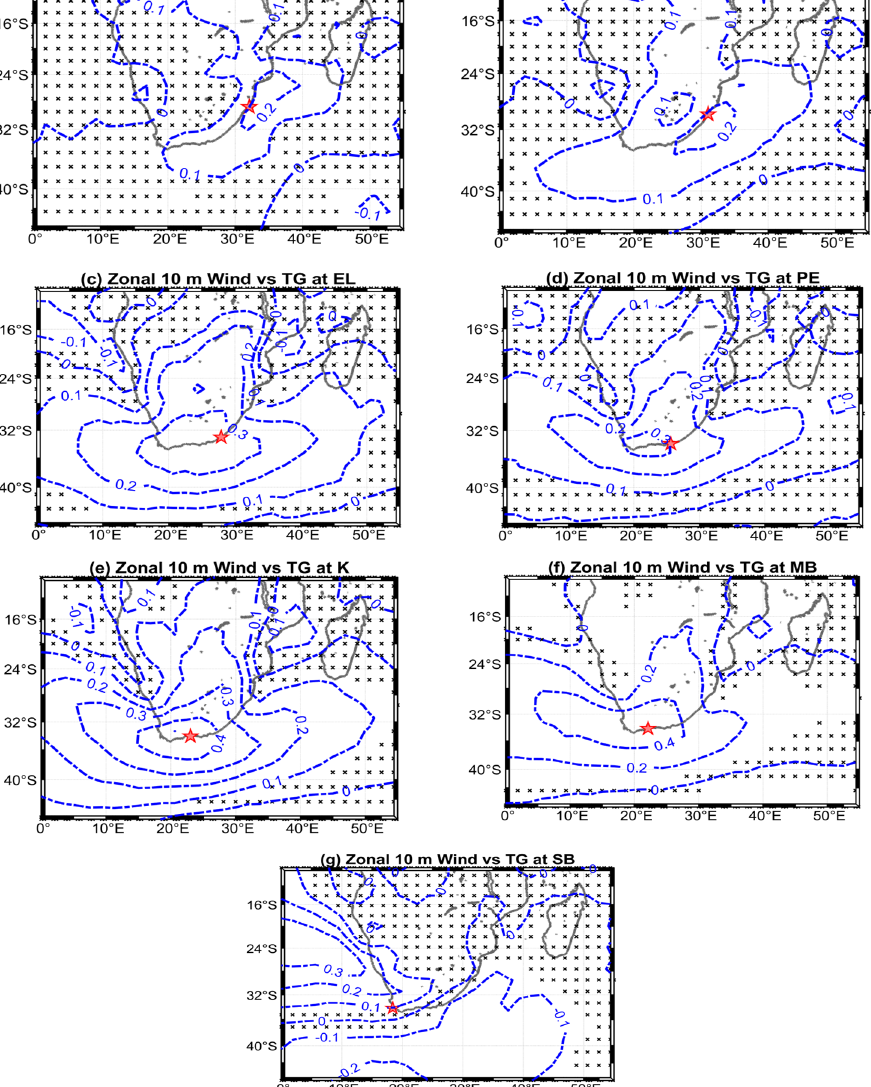
Figure 3. Correlation, on the sub-annual timescale, between regional gridded monthly mean zonal wind at 10 m above the mean sea surface and monthly mean sea level records at ( a ) Richards Bay, ( b ) Durban, ( c ) East London, ( d ) Port Elizabeth, ( e ) Knysna, ( f ) Mossel Bay and ( g ) Simons Bay, respectively. Red stars indicate the tide gauge location. Black crosses indicate areas statistically non-significant at 95% confidence level, estimated using a two-sided t -test.